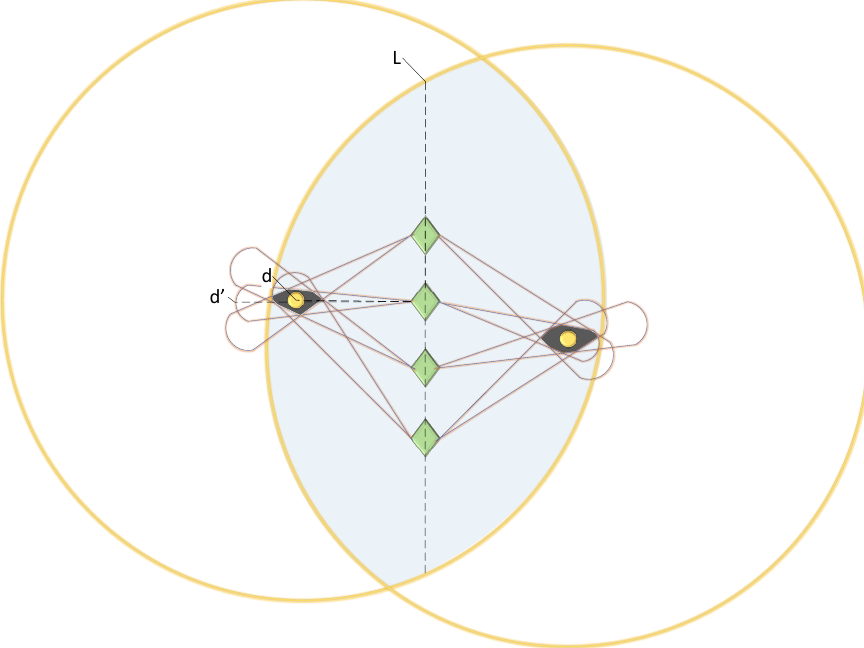
Figure 6. How the platform captures data packets and determines node